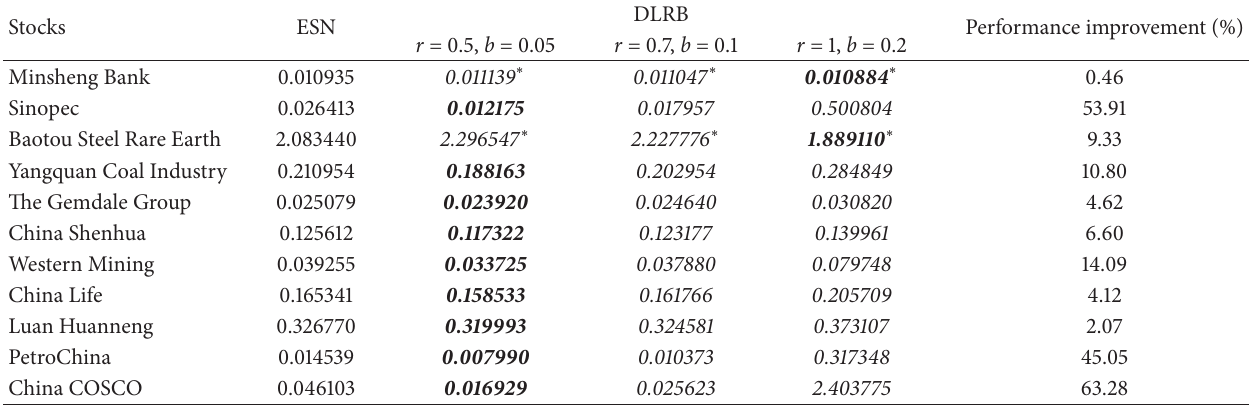
Table 2: Comparative results of ESN and DLRB by average forecasting accuracy (MSE).